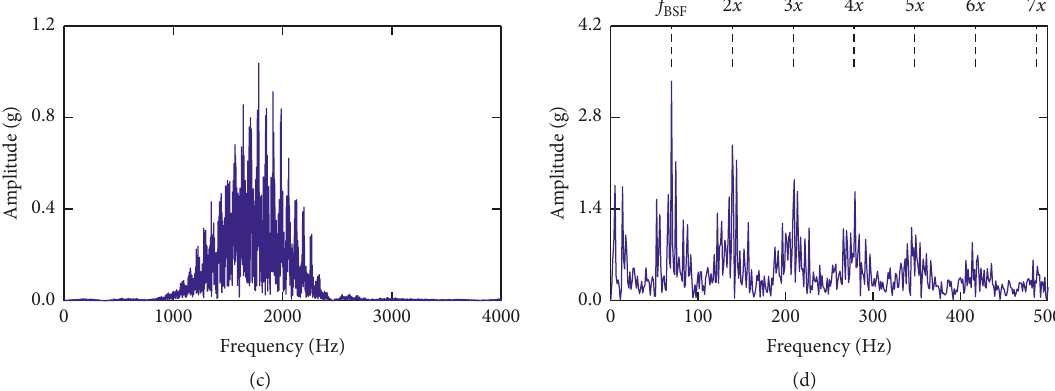
Figure 13: Separated impulsive components for the roller fault using the proposed method: (a) SES values for the different number of iterations; (b) separated impulse signal for the roller fault; (c) Fourier spectrum of (b); (d) Hilbert envelope spectrum of (c).